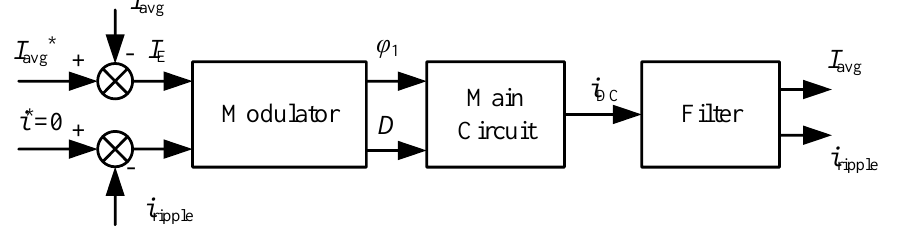
Figure 9. The overall control diagram for the proposed DC-AC DAB converter with DC side power decoupling.